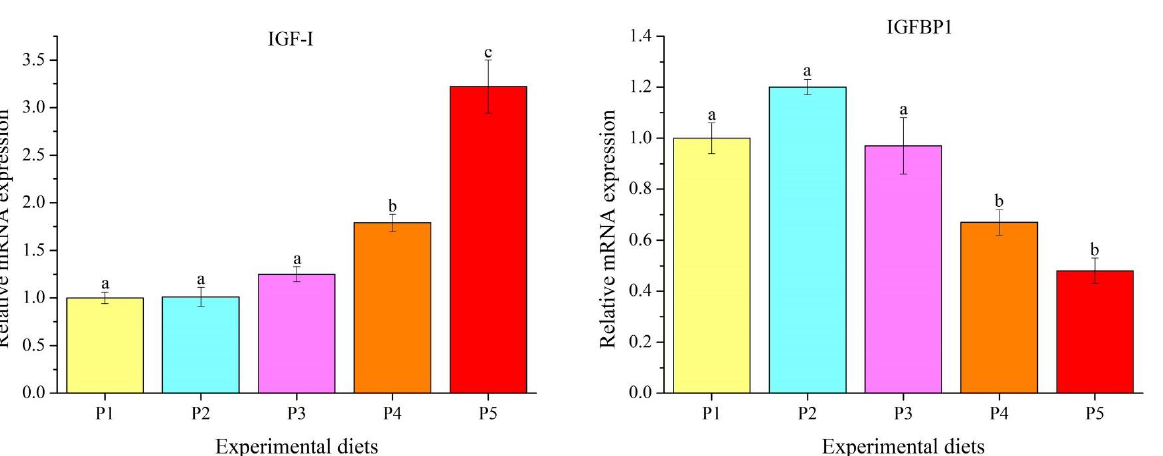
P1 and P2 diets ( p <